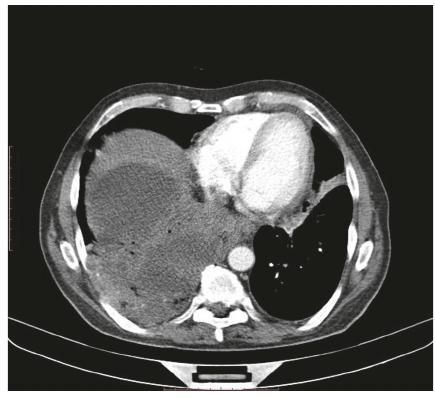
Figure 2: Ruptured hydatid cyst in lung via diaphragm on CT scan.